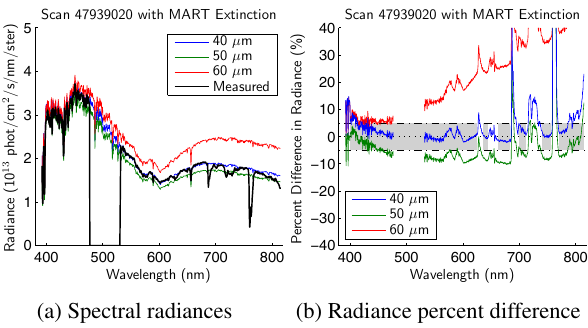
Fig. 14. Retrieved cirrus extinction for varying surface albedo, scan Fig. 14: Retrieved cirrus extinction for varying surface Fig. 14: Retrieved cirrus extinction for varying surface 47939020. albedo, scan 47939020. albedo, scan 47939020.